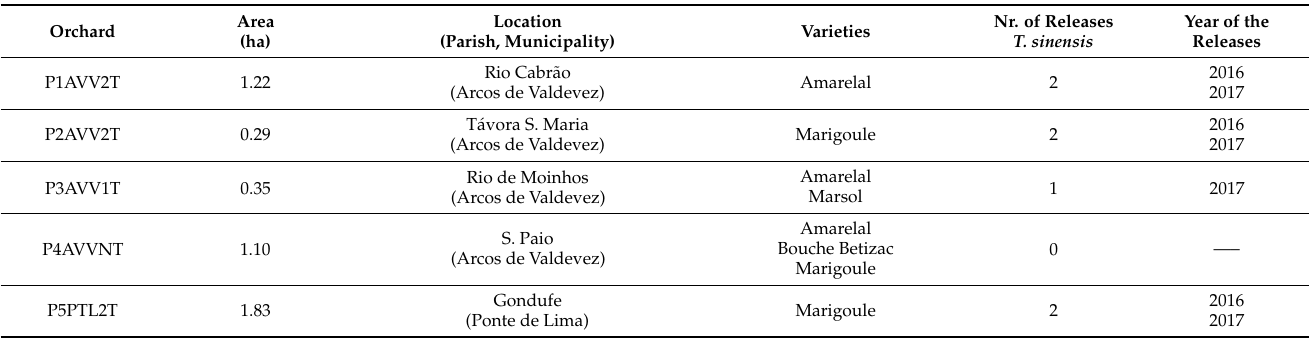
Table 1. Identification and characterization of the studied orchards (P1 to P5) in Arcos de Valdevez (AVV) and Ponte de Lima (PTL), with one (1T), two (2T) or no treatment (NT) of T. sinensis